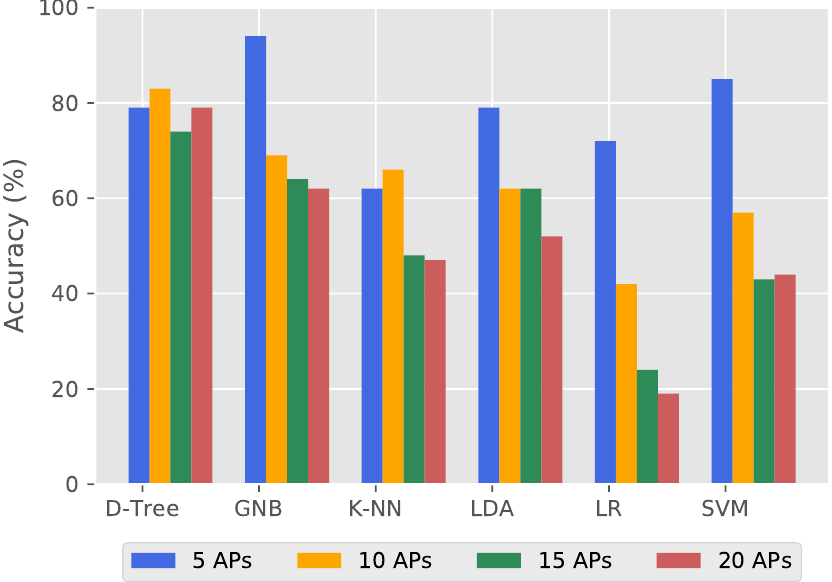
Figure 4. Average accuracy with different number of APs using RD